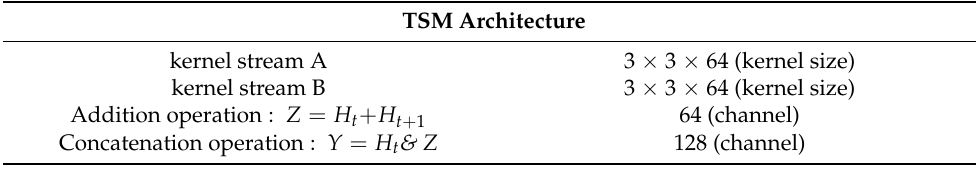
Table 1. The architecture of the TSM.